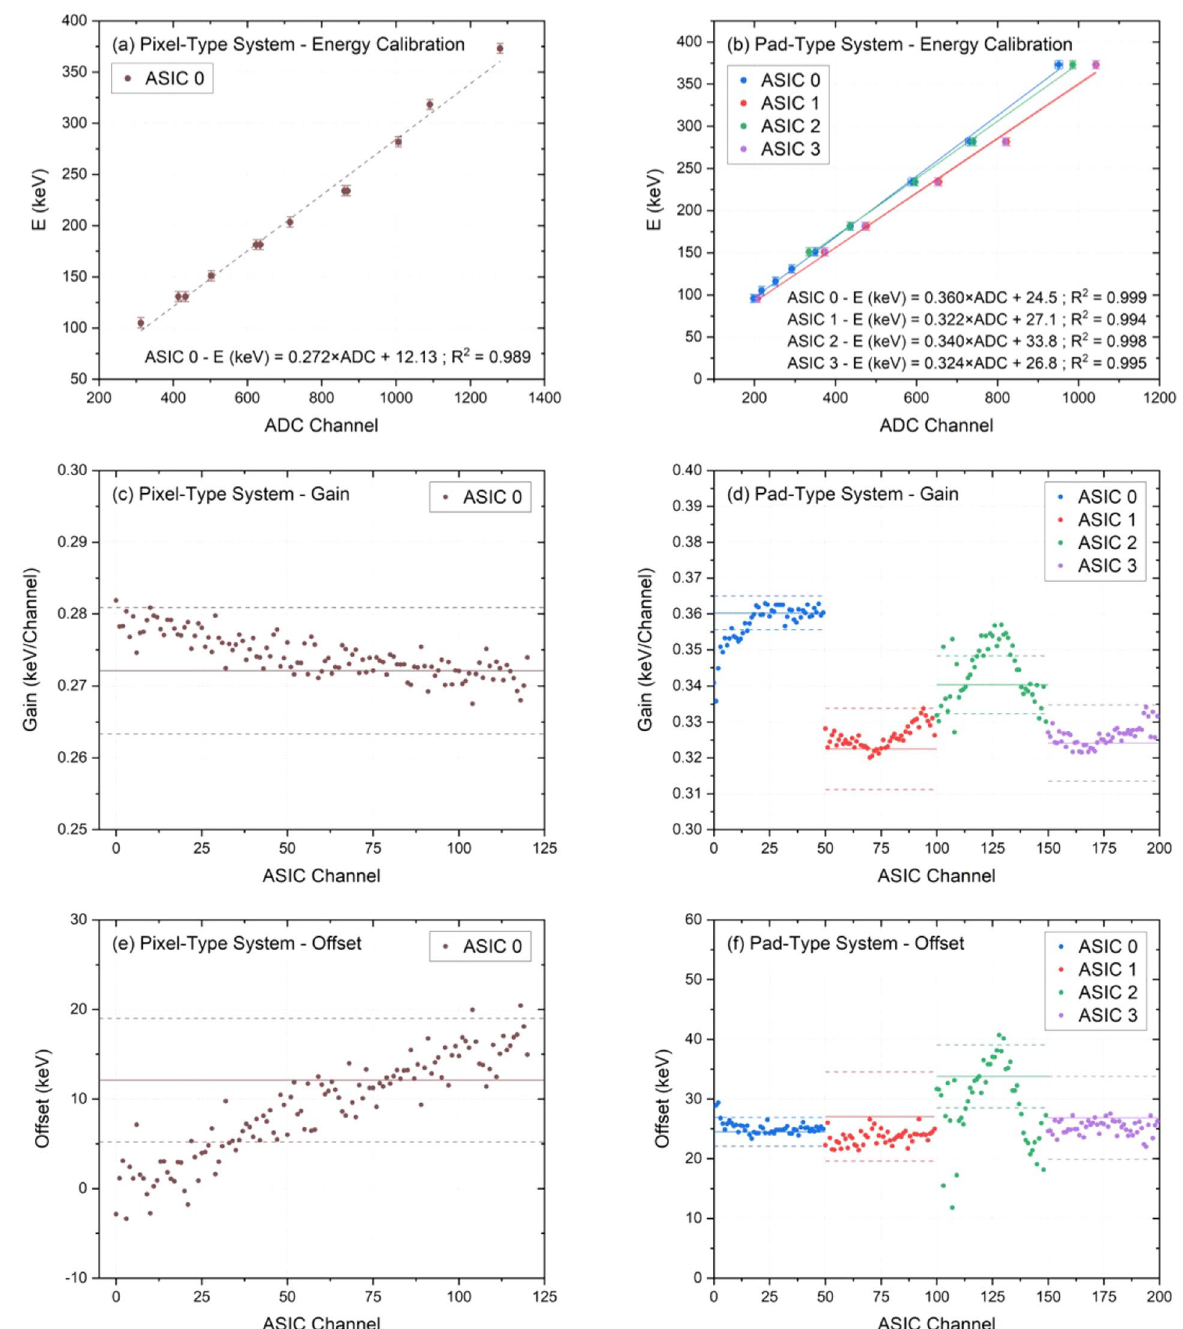
Figure 4. ( a ), ( b ) Energy calibration curves for the pixel- ( a ) and pad-type ( b ) systems. The deposited energies calculated with SRIM simulations were fitted to the ADC channels obtained from the experimental spectra with a linear model. ( c )–( f ) Gain and offset values distribution for all the connected channels in each system. The solid lines indicate the mean values obtained with the full ROC energy calibration, and the dashed lines correspond to the uncertainty limits of those values. Channels belonging to different ROCs are displayed in different